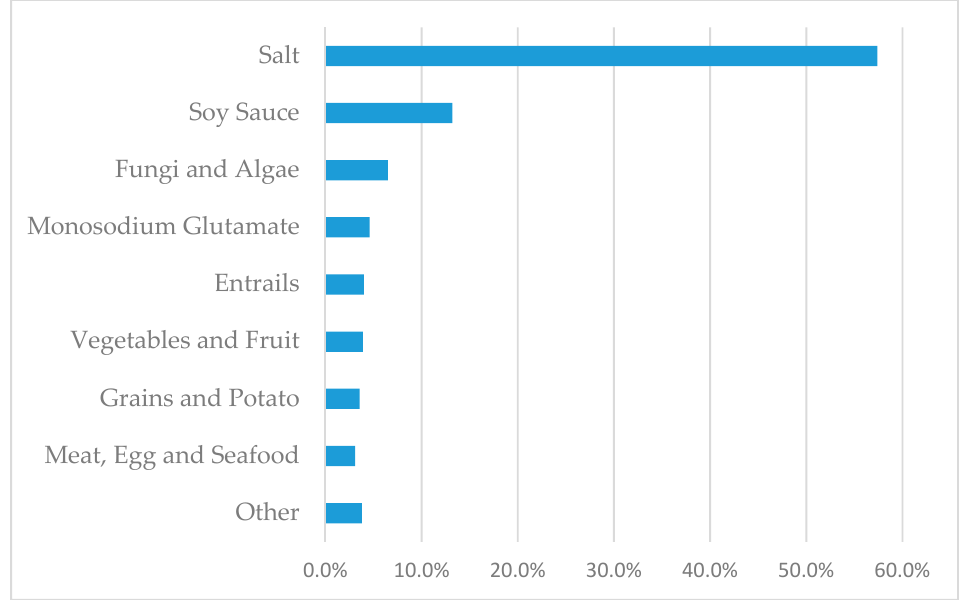
Figure 1. Dietary sources of sodium among 3958 participants from SDHS in 2015. After adjusting for age and sex, a significant partial correlation was determined between dietary salt and sodium (0.881, p < 0.05; Table 2). Table 2. Partial correlation coefficient between dietary sodium and salt. Dietary Sodium Dietary Salt Dietary sodium 1 0.881 a Dietary